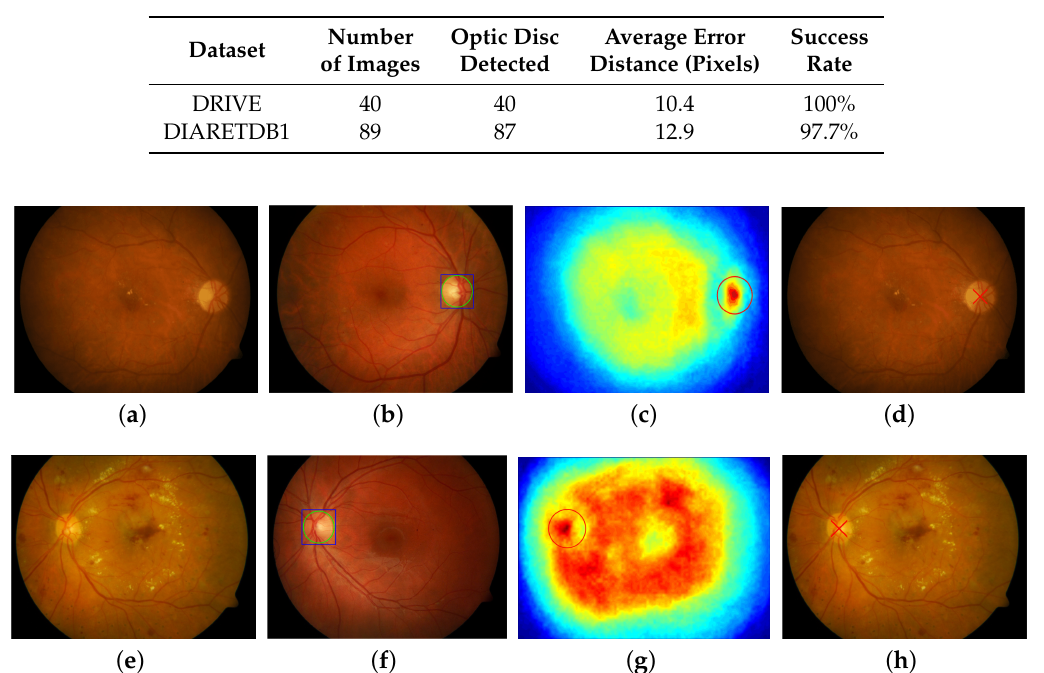
Figure 2. The steps of our method to detect ODs in normal fundus photography and fundus photography containing pathologies. ( a , e ) Target image. ( b , f ) The blue rectangle is marked as the template, the green circle is the true optic disc. ( c , g ) Confidence map. The red circle is the result of our method in the confidence map. ( d , h ) The red cross is the final detection